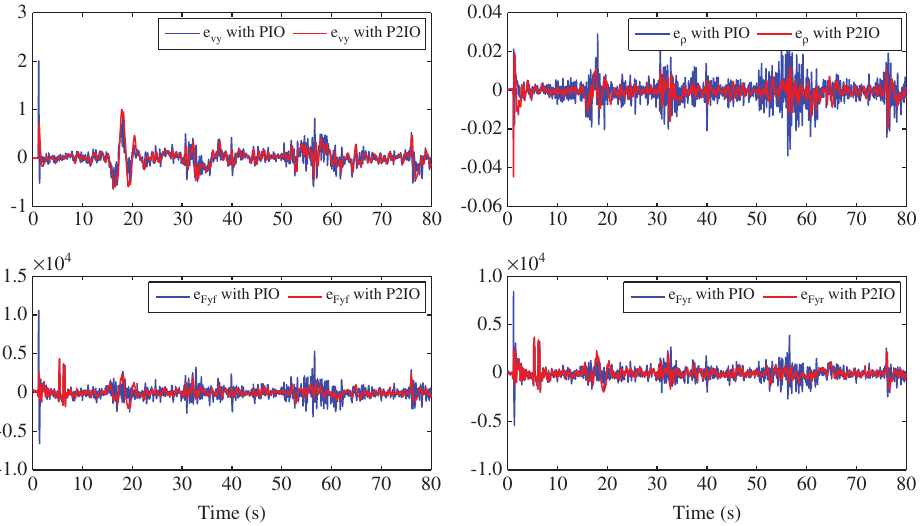
Figure 5. Comparison PI and P2I